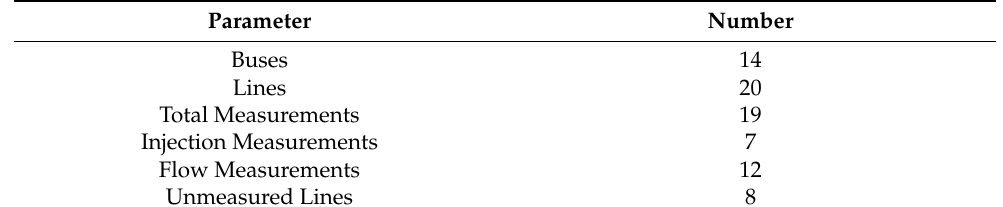
Table 1. Information of the IEEE14-bus Test System.